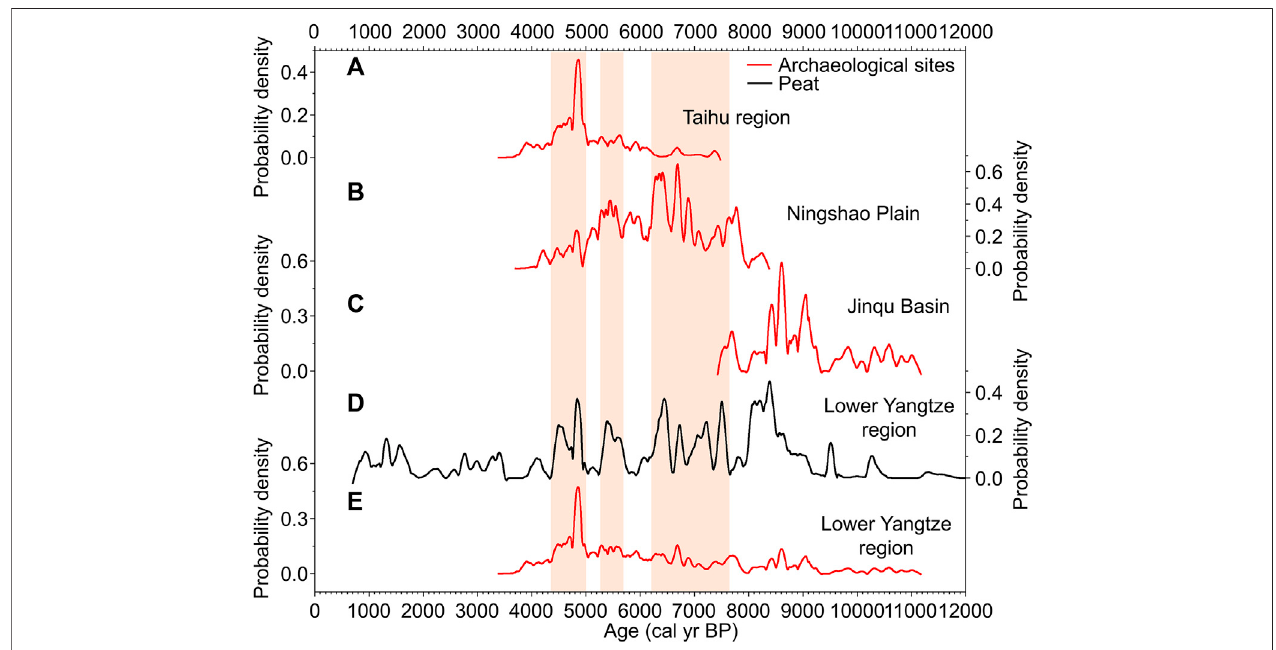
FIGURE6| Comparison betweentheSPD ofradiocarbon datesofarchaeologicalsites and peat. (A) SPDofarchaeologicalradiocarbon datesintheTaihuregion. (B) SPDofarchaeologicalradiocarbondatesintheNingshaoPlain. (C) SPDofarchaeologicalradiocarbondatesintheJinquBasin. (D) SPDofradiocarbondatesofpeat inthelowerYangtzeregion. (E) SPDofarchaeologicalradiocarbondatesinthelowerYangtzeregion.Alltheseare200-point-smoothingresults.Orangebandsshowthe peak periods of radiocarbon dates of archaeological sites and peat.